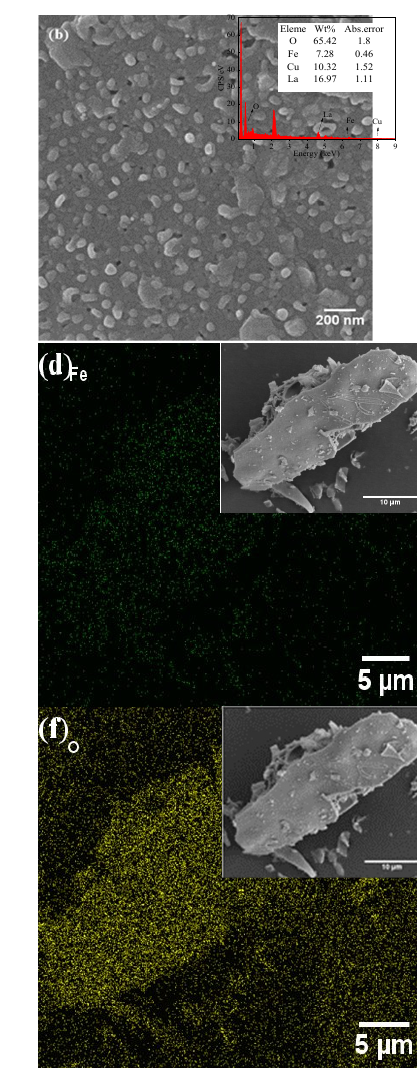
4 of 16 Figure 1. XRD patterns ( a ); and FTIR spectra ( b ) of LCFO catalyst, enlarged XRD patterns ( c ) and XRD patterns of refinement and used catalyst ( d ). The N 2 adsorption/desorption isotherms of LCO-4 catalysts are also summarized and shown in Figure 2a. The BET surface area of LCFO-4 was found to be 10.8 m 2 /g, and the particle size was determined to be 40.4 nm. The type IV isotherm indicates the presence of mesopores in the catalyst, which could indicate good catalytic activity in the degrada- tion of BPA. The morphologies of the LCFO-4 catalyst were determined by SEM ‒ EDS. As seen in